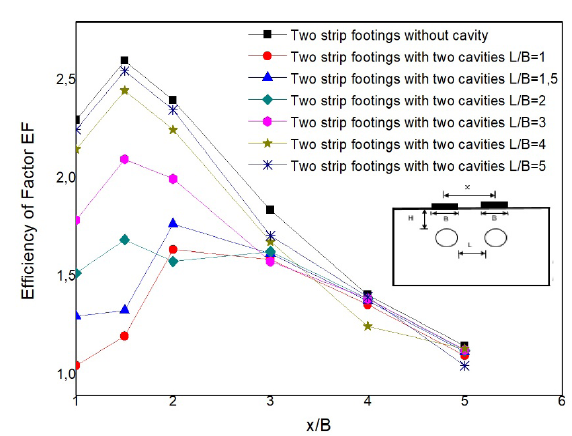
Figure 12: Variation of EF as a function of x/B in the following cases: two strip footings without cavity and with cavity (H/B = 1); (L/B